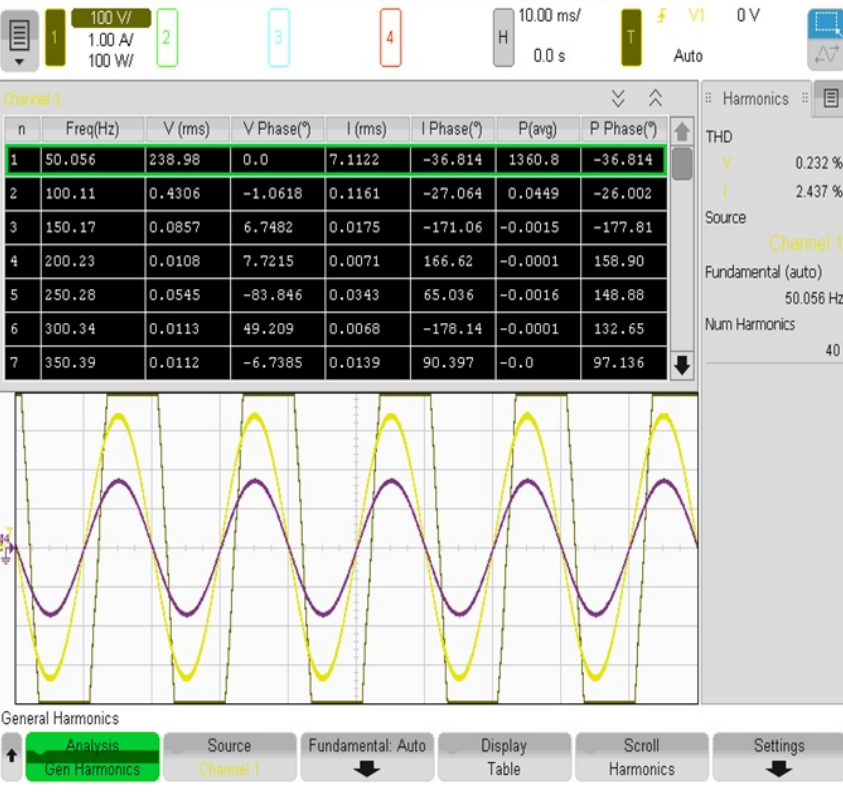
Figure 15. Voltage sag conditions in grid connected to induction motor under loaded conditions. Table 3. Induction motor under loaded conditions [neutral not connected].